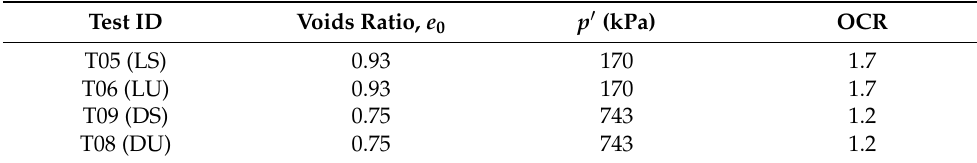
Table 5. Initial condition of the axisymmetric